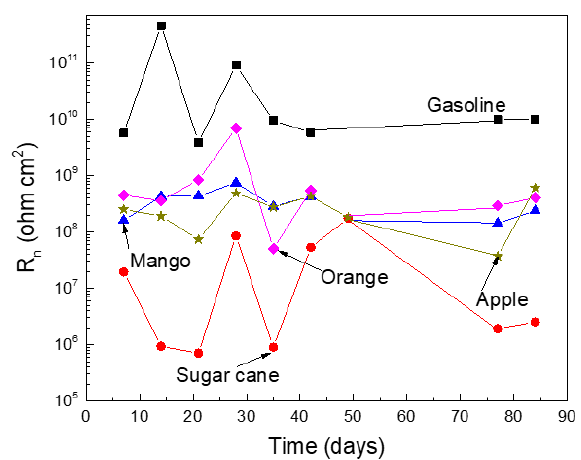
Figure 5. Variation on the R n value for Al in the different ethanol–gasoline blends.